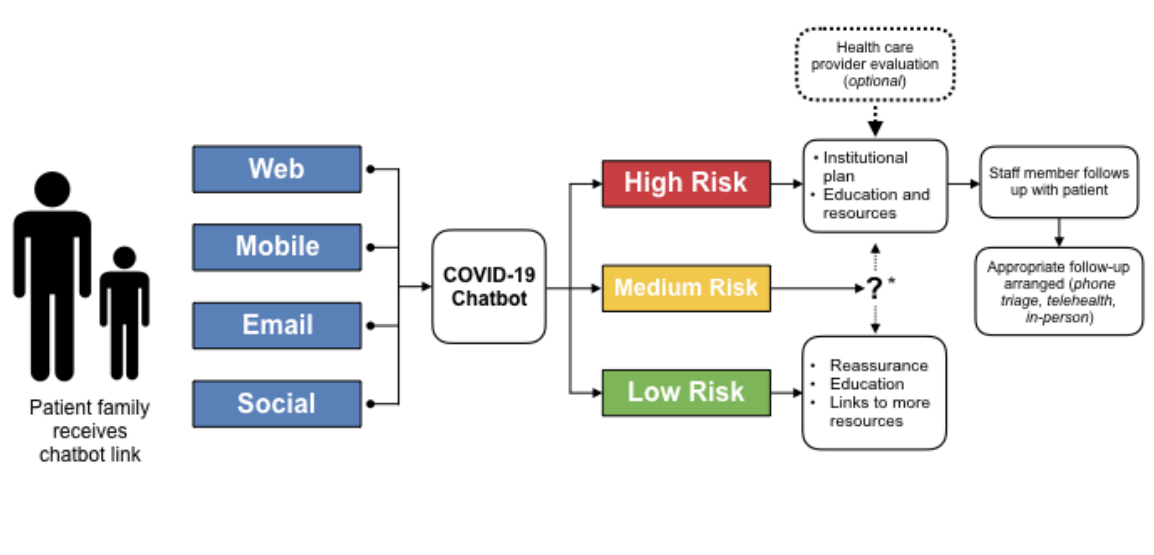
Figure 1. Sample chatbot process map. *: Institutional discretion, follow public health agency